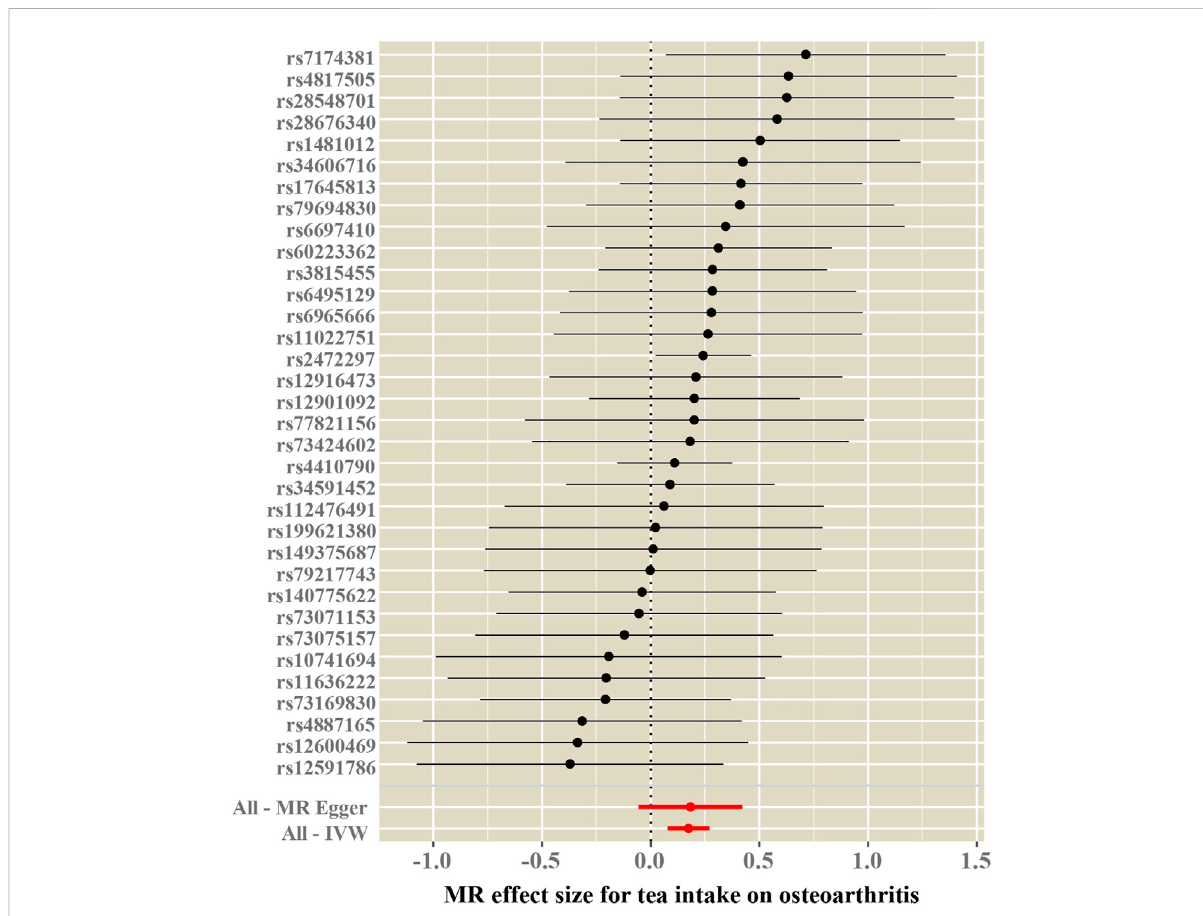
FIGURE 5 Forest plot of the effect size for each SNP on tea consumption and